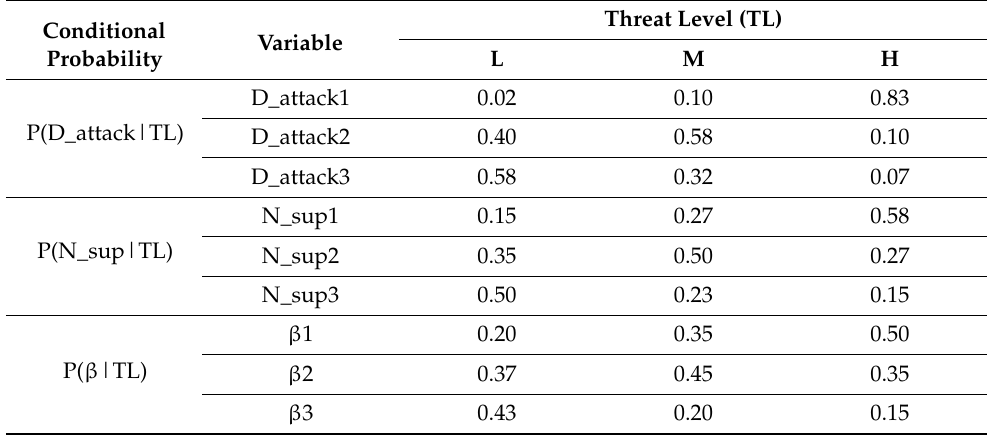
Table 1. Dynamic Bayesian Network conditional probabilities for HVU threat